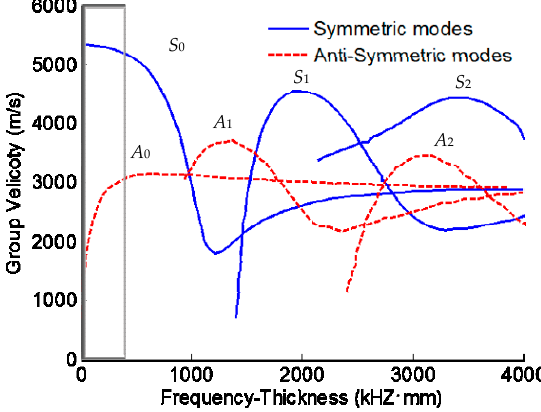
Figure 2. Dispersion curves of Lamb wave of a 2 mm aluminum plate.